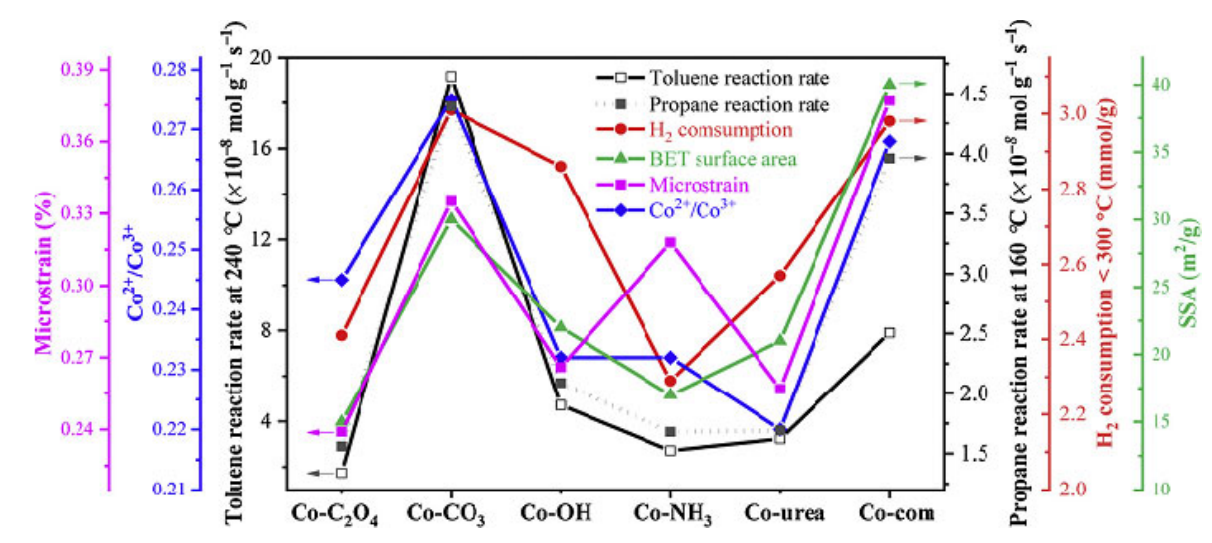
Figure 4. The relationship between the catalytic reaction rate and several physical and chemical parameters. Reprinted with permission from Ref. [60]. Copyright 2020 Elsevier.